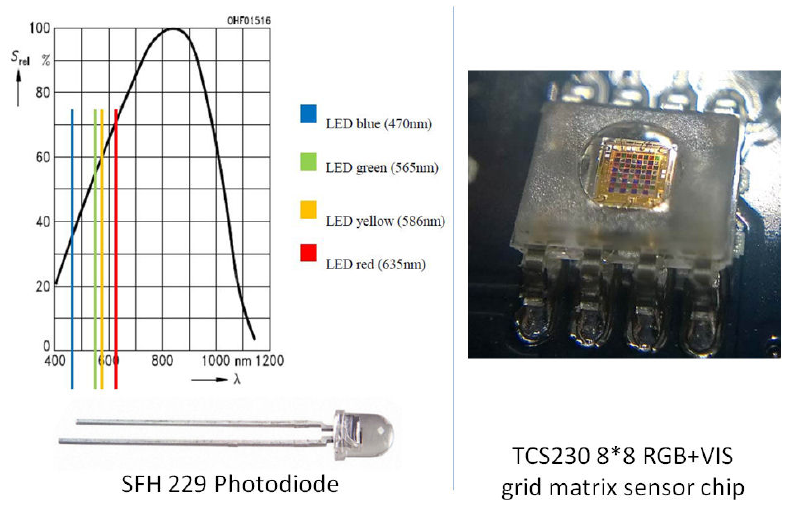
Figure 5. Sensor selection: ( Top ) analogue-digital approach and ( bottom ) fully digital approach at sensing.